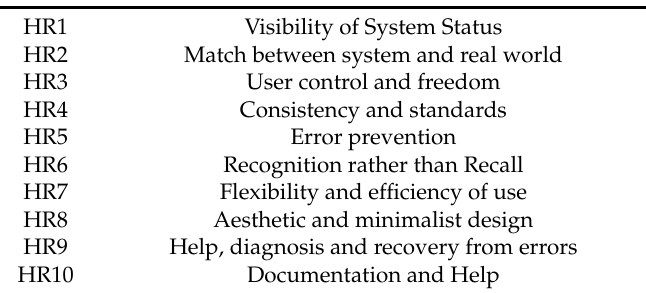
Table 1. Nielsen’s Ten Heuristic Principles.